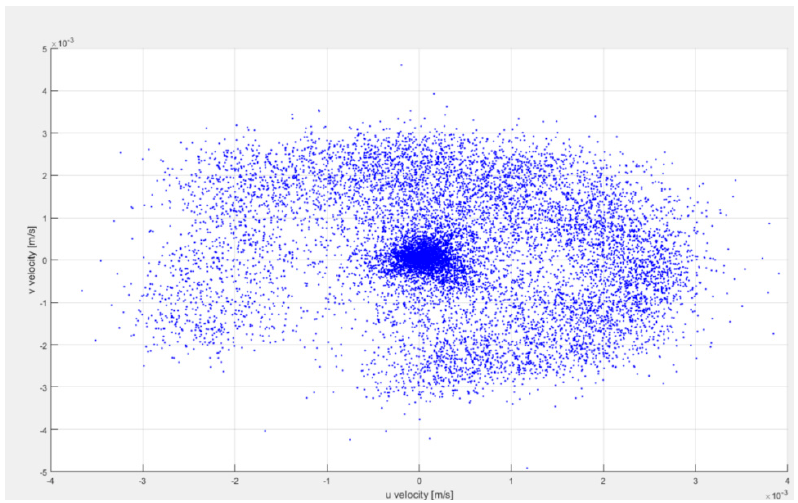
Figure 13. Scatter plot of velocity components u & v, from 2D PIVLAB toolbox analysis results for experiment C.